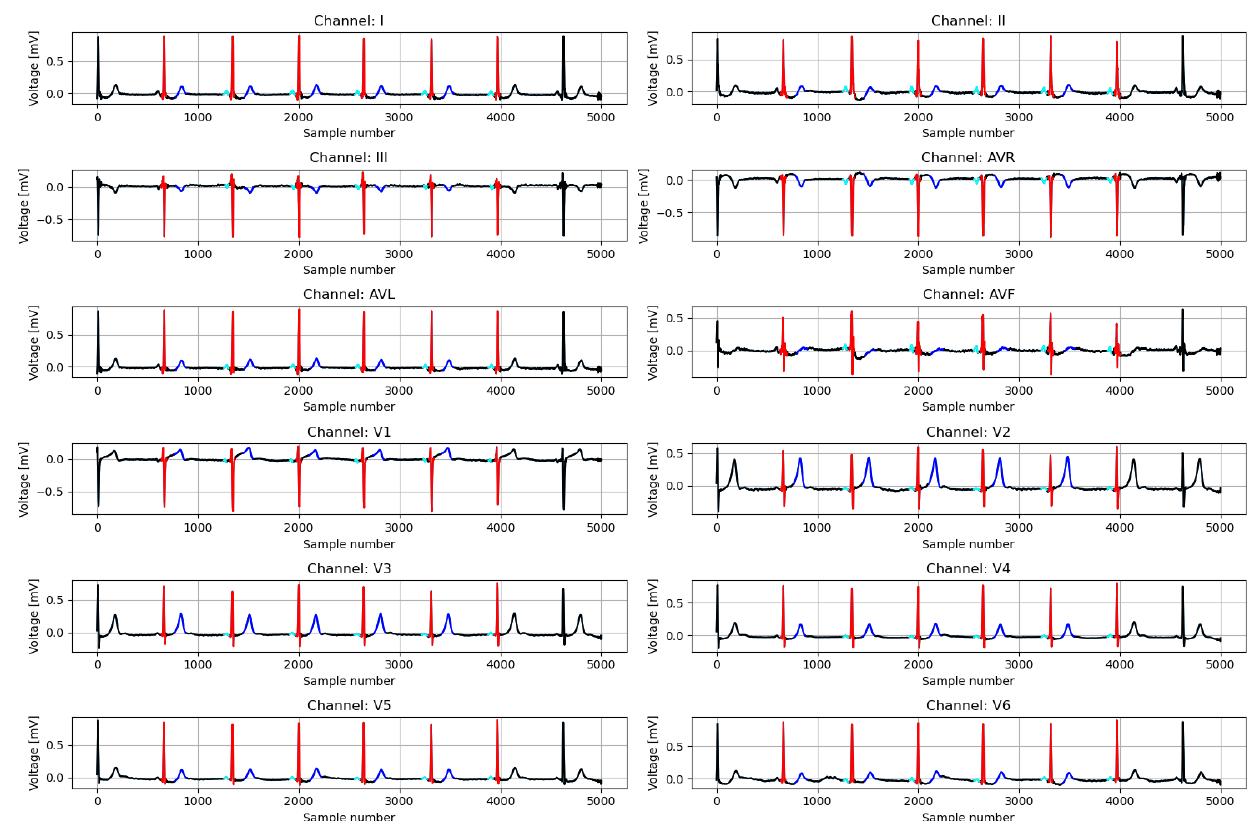
Figure 10. The result of the segmentation using the model on all twelve leads of the ECG